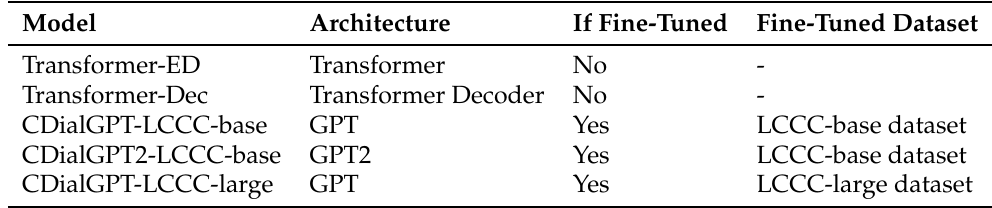
Table 1. Comparison of the previous works.